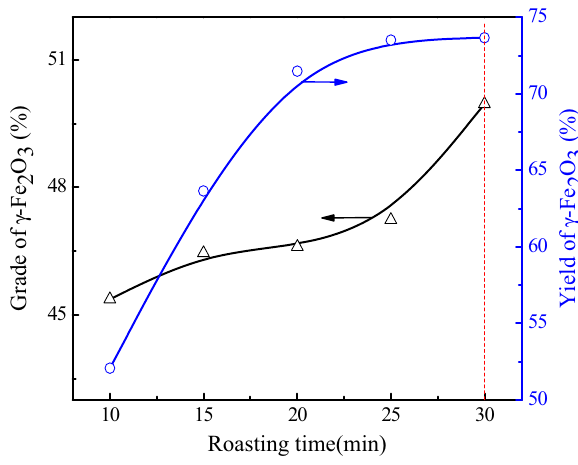
Figure 3: E ff ect of roasting time on γ - Fe 2 O 3 recovery.